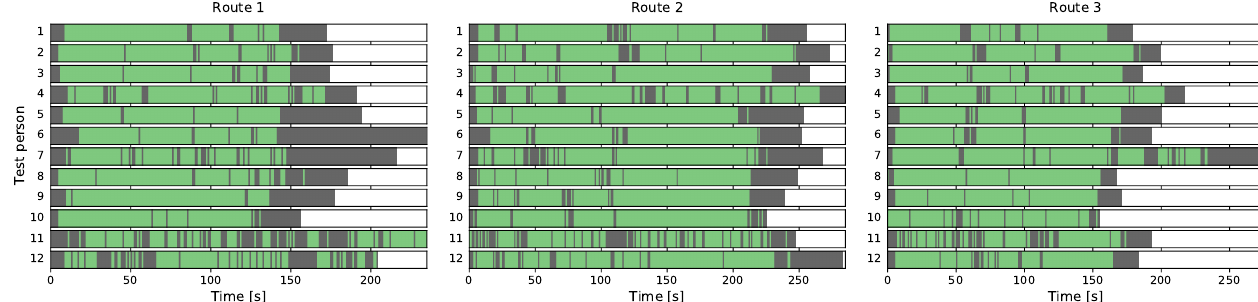
Figure 11. Results of the locomotion/stationary classifier for the three test routes and 12 participants each. (green, locomotion; grey,